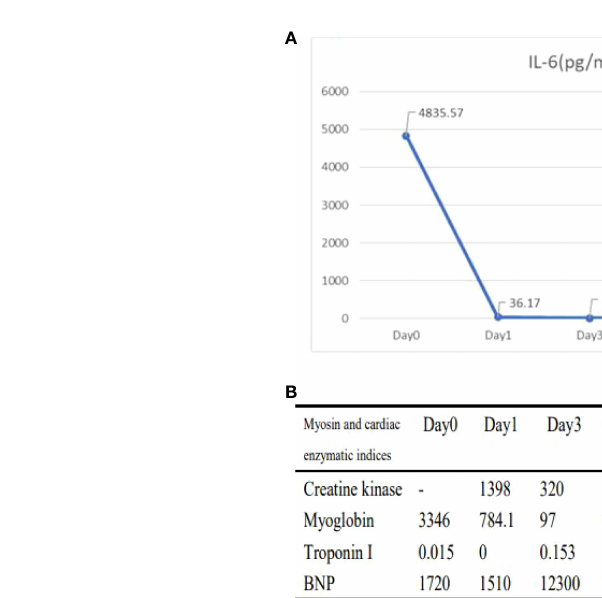
FIGURE 4 Changes in laboratory indicators during the onset of immune-related toxicity in patients (A, B) . (A) : Changes in IL-6 (Day0 represents the level after 0 days of steroid treatment; Day1 represents the level after 1 days of steroid treatment; Day3 represents the level after 3 days of steroid treatment; Day10 represents the level after 10 days of steroid treatment; Day21 represents the level after 21 days of steroid treatment.) (B) Changes in cardiac parameters (Day0 represents levels after 0 day of steroid treatment; Day1 represents levels after 1 day of steroid treatment; Day3 represents levels after 3 days of steroid treatment; Day4 represents levels after 4 days of steroid treatment; Day5 represents levels after 5 days of steroid treatment; Day8 represents levels after 8 days of steroid treatment).